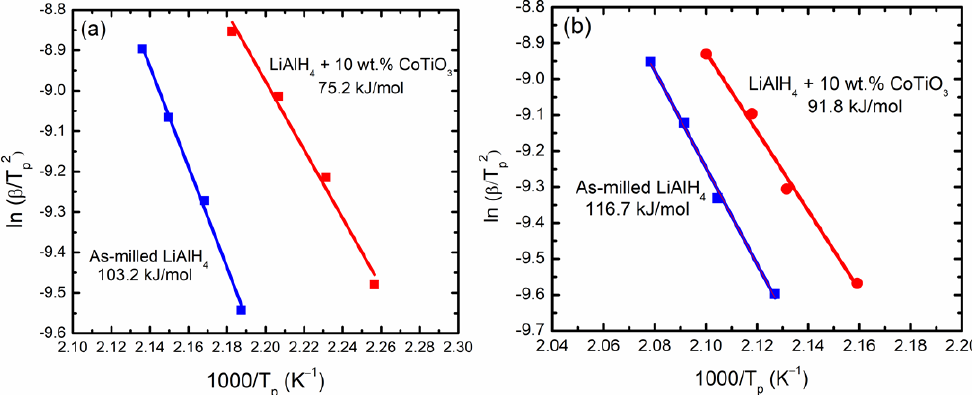
Figure 5. Kissinger plot of ( a ) first and ( b ) second desorption stage of as-milled LiAlH 4 and LiAlH 4 + 10 wt.% CoTiO 3 .